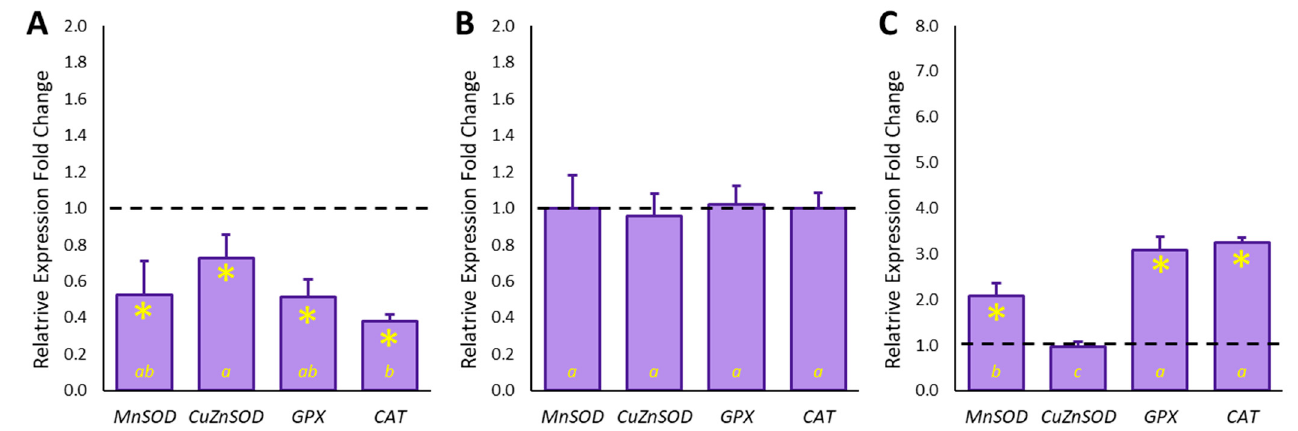
Figure 2. Relative expression of superoxide dismutase ( SOD ), catalase ( CAT ), and glutathione peroxidase ( GPx ) gene in HepG2 cells. Panel A shows the relative gene expression of cells treated for 24 h with 200 µM H 2 O 2 in comparison with untreated cells. Panel B shows the relative gene expression of cells treated for 2 h with E. involucrata fruit extract in comparison with untreated cells. Panel C shows the relative gene expression of cells treated for 2 h with the fruit extract, and then exposed to 200 µM H 2 O 2 for 24 h in comparison with cells exposed to 200 µM H 2 O 2 for 24 h. For all experimental conditions, β -actin was used as the reference gene. The bars represent the mean ± SD of three qRT-PCR analyses performed in triplicate. Different lowercase letters at the bottom of each bar indicate significant differences in the obtained values, as measured by Tukey’s test ( p ≤ 0.05). The asterisk (*), when present, indicates statistical differences ( p ≤ 0.05) between the control condition (dashed line) and the treated condition.